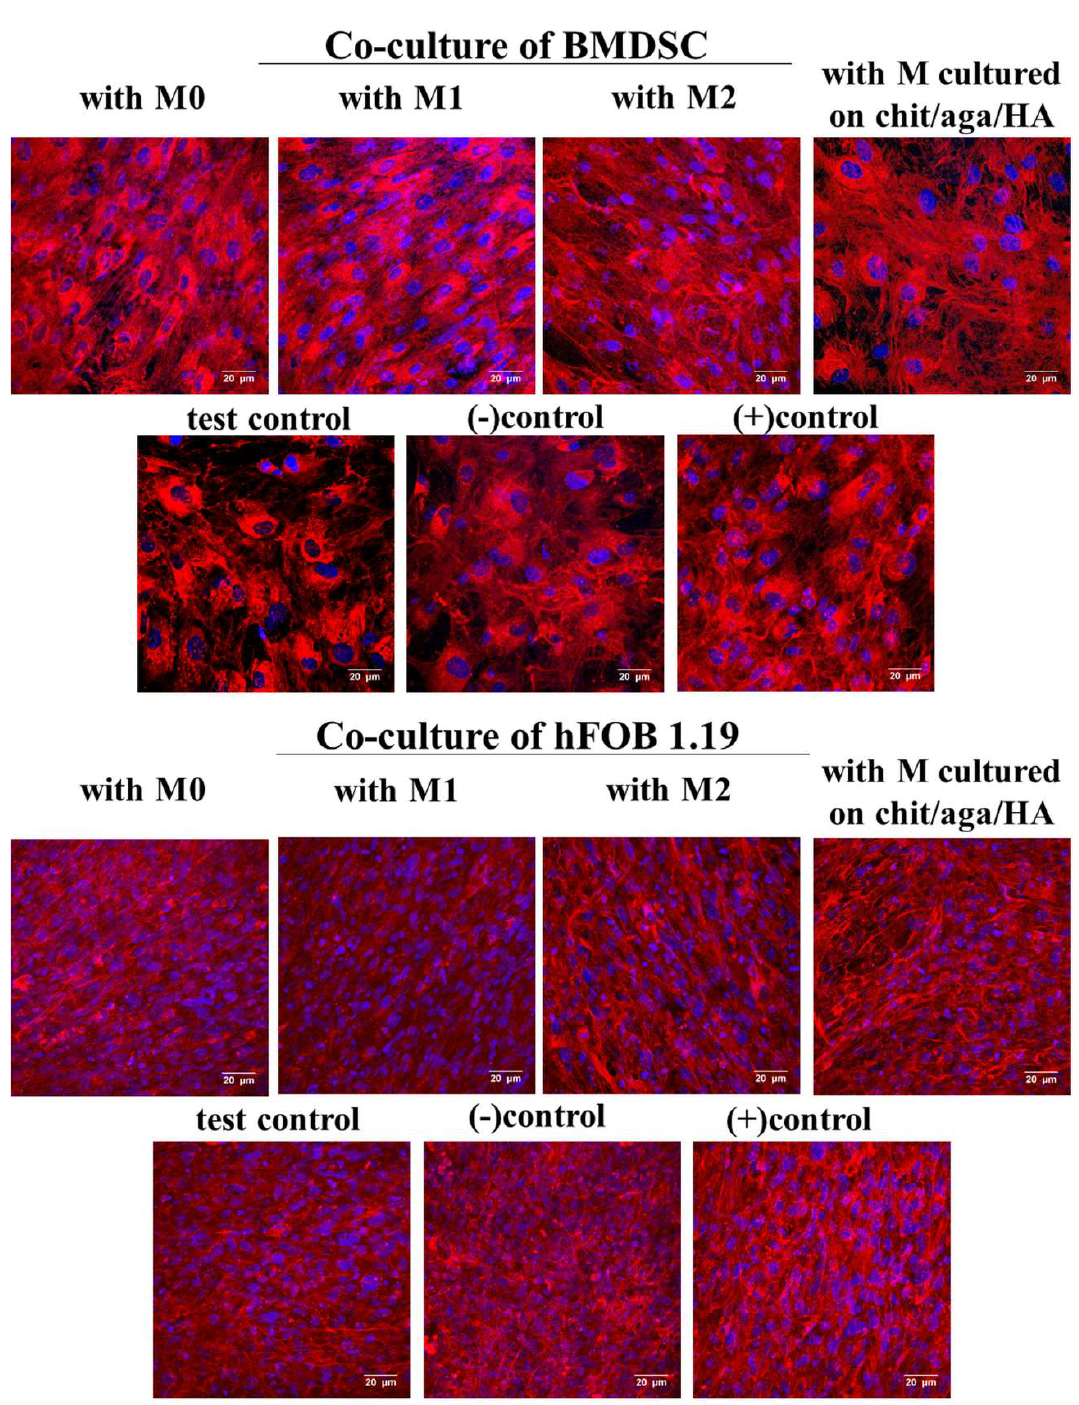
Figure 6. Confocal laser scanning microscope images presenting immunofluorescent staining of type I collagen in the extracellular matrix (ECM) of human bone marrow-derived stem cells (BMDSC) and normal human fetal osteoblast cell line (hFOB 1.19) co-cultured with M0, M1, and M2 macrophages as well as macrophages grown on the surface of chit/aga/HA biomaterial; The following controls were applied in the experiment: test control—monoculture of BMDSC or hFOB 1.19 cells grown in the presence of chit/aga/HA (without macrophages), (-)control—monoculture of BMDSC or hFOB 1.19 cells in the absence of chit/aga/HA in medium without dexamethasone, (+)control—monoculture of BMDSC or hFOB 1.19 cells in the absence of chit/aga/HA in complete osteogenic medium with dexamethasone; red fluorescence—type I collagen, blue fluorescence—nuclei; magnified 400×, scale bar = 20 µm.